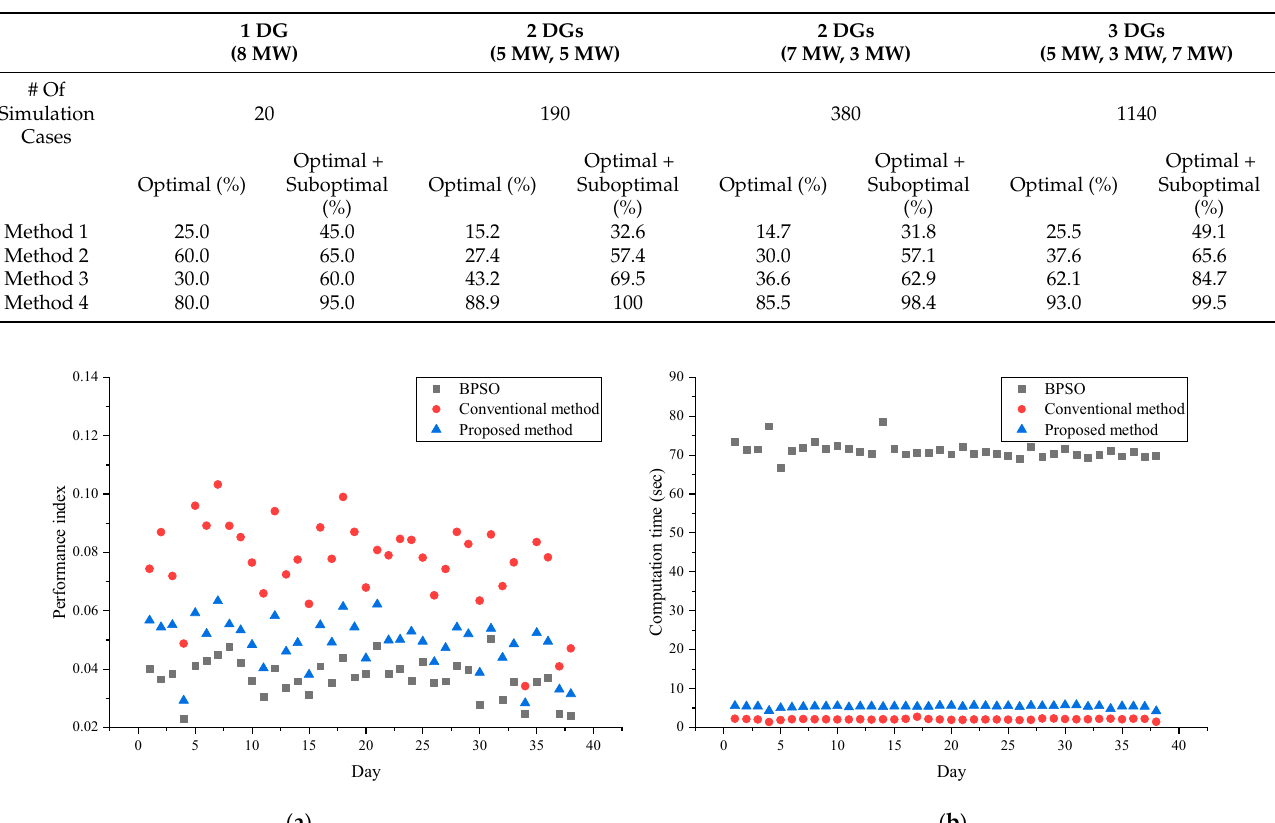
Table 1. Probabilities of finding optimal and suboptimal solutions using each compared method.